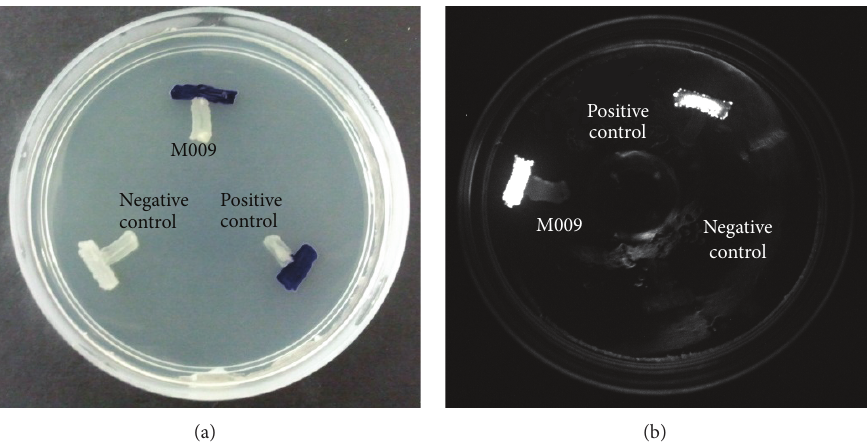
Figure 1: (a) AHL screening of strain M009 with CV026. E. carotovora PNP22 (Negative control) devoid of QS activity was included and E. carotovora GS101 (Positive control) that can activate CV026 was included for comparison. Both positive control and strain M009 induce the purple violacein pigmentation. (b) AHL screening of strain M009 with E. coli [pSB401]. E. carotovora PNP22 (negative control) and E. carotovora GS101 (positive control) served as negative and positive controls, respectively. The positive control and strain M009 exhibit bioluminescence.